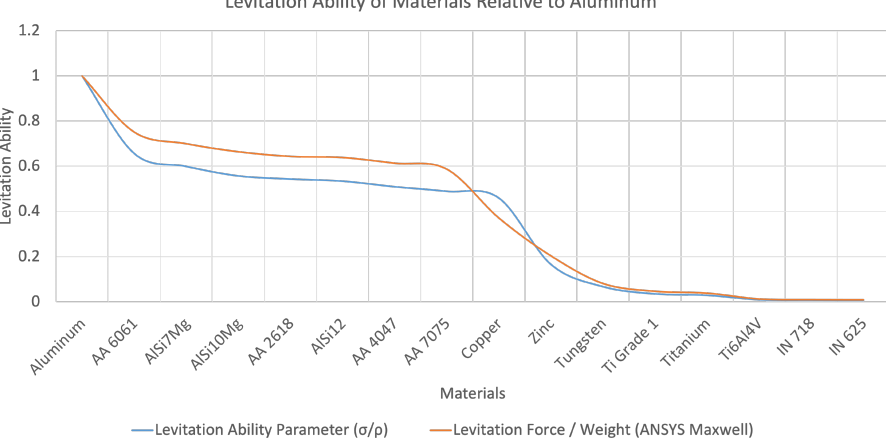
Figure 19. Levitation ability. Analytical model,